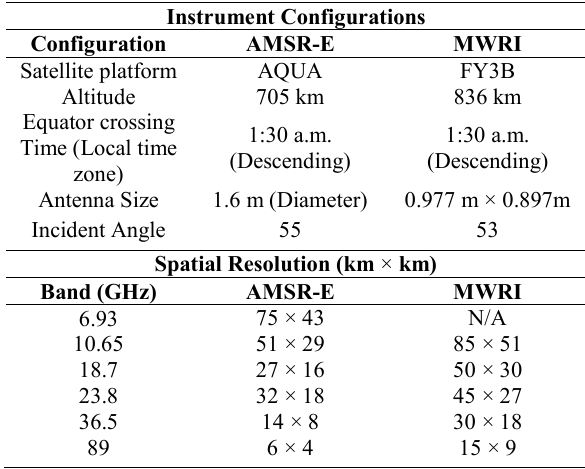
Table 1. The main configurations of AMSR-E and